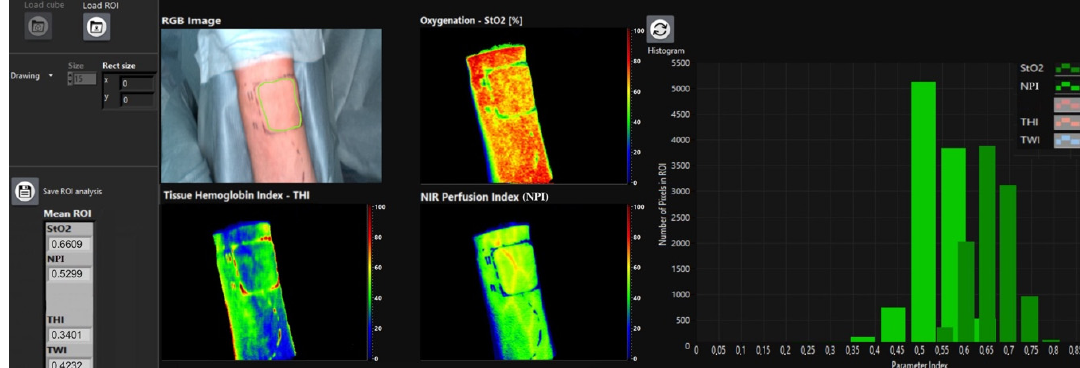
Figure 2. HSI shows the blood flow measured in the left ulnar flap raise site (t0) with the region of interest (ROI) marked manually (green line, RGB image). The quality of blood flow is indicated by false colors ranging from blue (low) to red (high). On the left, quantification of ROI is listed and shows mean values of the respective parameters (StO 2 , NPI, THI, TWI). The number of assessed pixels and the corresponding amount of StO 2 and NPI within ROI ( Y -axis) is represented as a bar chart.